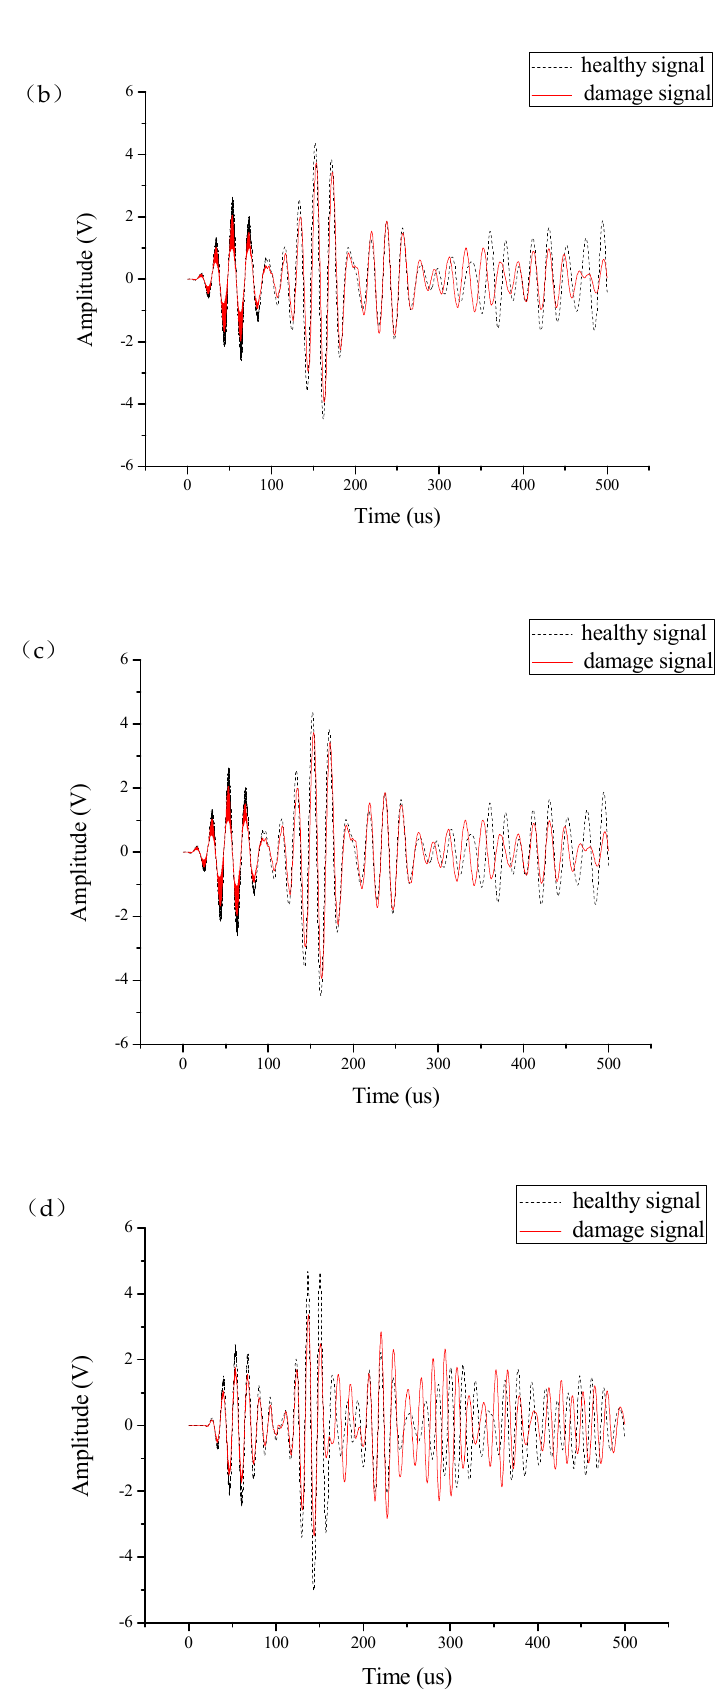
Figure 6. Piezoelectric sensor monitoring results with di ff erent excitation frequencies: ( a ) 40 kHz; ( b ) 50 kHz; ( c ) 60 kHz; ( d ) 70